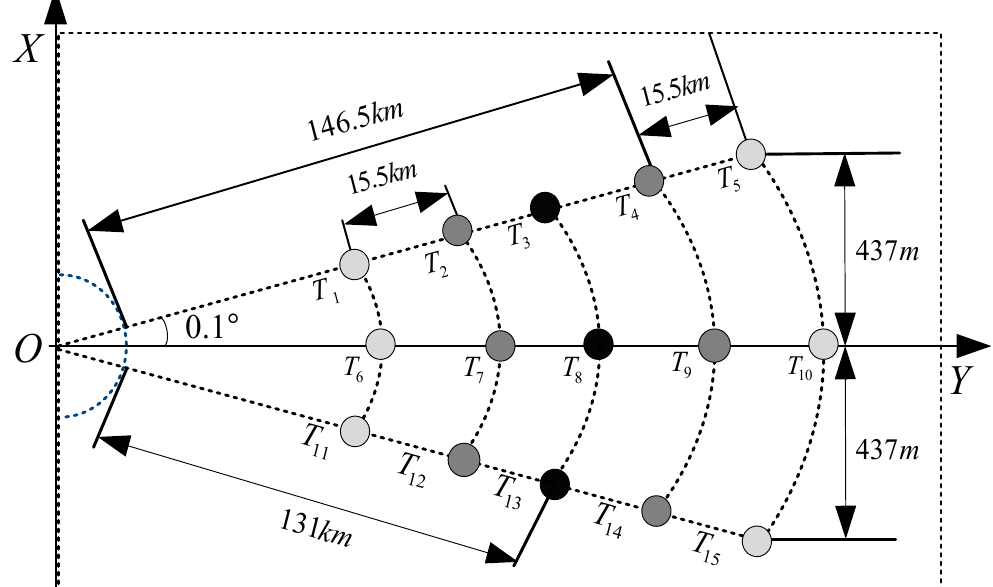
Figure 8. Point targets distribution for SAR imaging simulation.